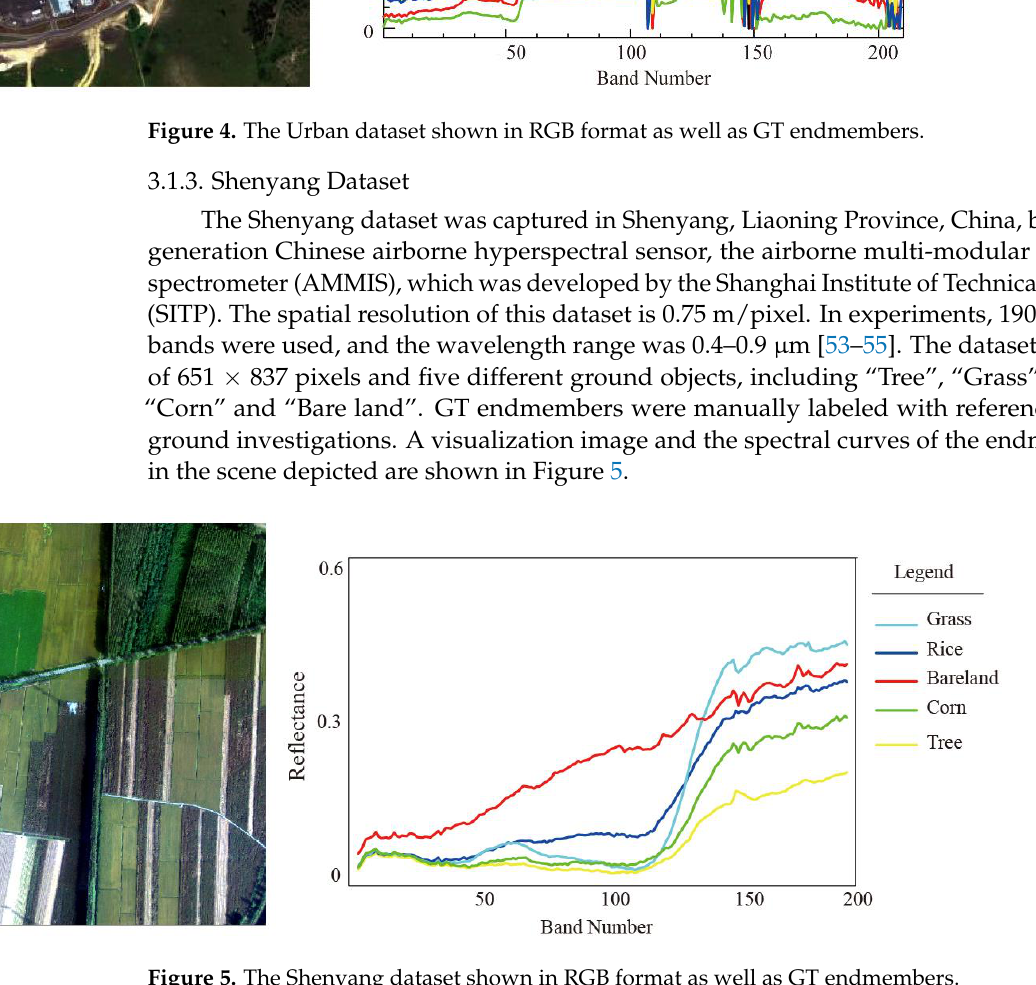
Figure 4. The Urban dataset shown in RGB format as well as GT endmembers.